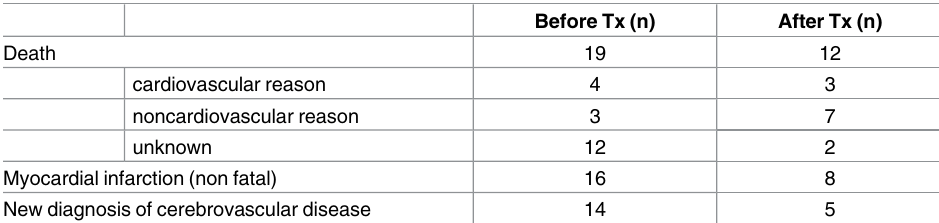
Table 2. Events during